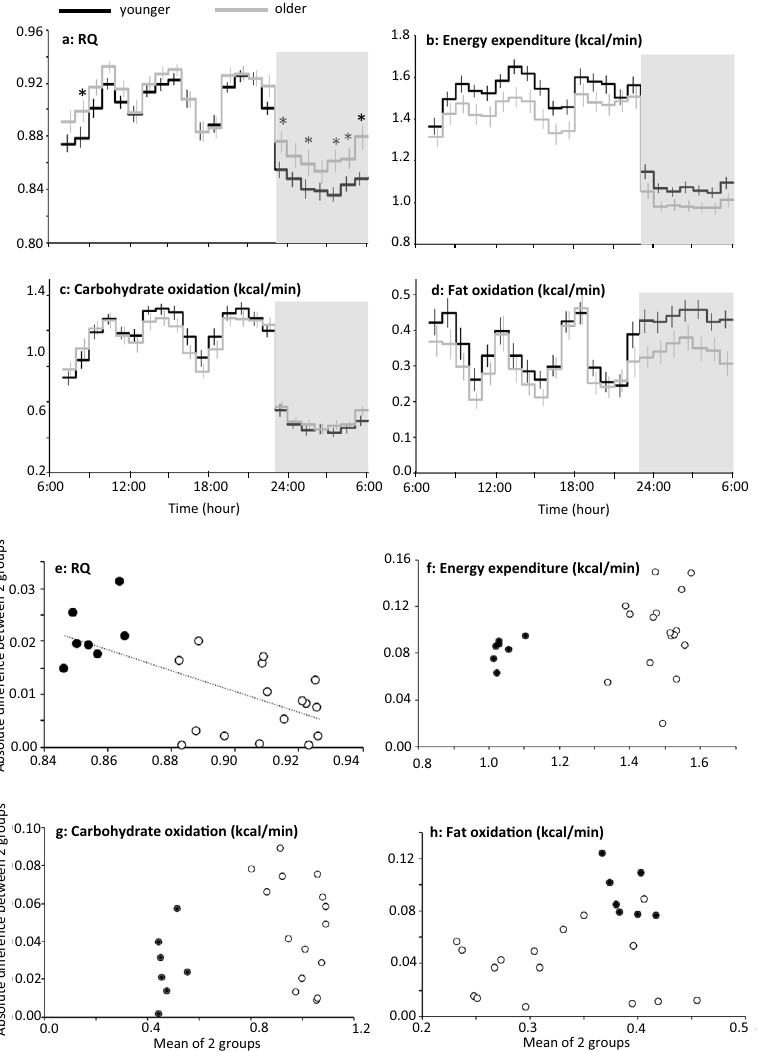
Figure 3. Time course of energy metabolism in two age groups of 10 years apart. ( a – d ) Fifty-three men were grouped as younger (n = 27, under 25 years of age) or older (n = 26, 25 years or more) 9,19–22 . Subjects took breakfast (7:00, 8:00 or 9:00), lunch (12:00, 12:30 or 13:00), and dinner (18:00), and slept for 7 or 8 h from 23:00 (grey bars). Because of unequal duration of sleeping period, the 8th hour of sleep in one experiment was not included for statistical analysis 9 . Mean ± SE of RQ, energy expenditure, carbohydrate oxidation and fat oxidation for 23 h common to all data sets were shown for younger (black lines) and older (grey lines) group. A linear mixed-models ANOVA showed a significant effect of time (P < 0.01) and a group × time interaction (P = 0.032), but main effect of group was not significant (P = 0.078) for RQ. Similarly for carbohydrate oxidation, significant effect of time (P < 0.01) and a group × time interaction (P = 0.043) were found, but main effect of group was not significant (P = 0.792). For energy expenditure and fat oxidation, main effect of time was significant (P < 0.01), but main effect of group (P = 0.066 for energy expenditure and P = 0.129 for fat oxidation) and group × time interaction was not significant (P = 0.376 and P = 0.290). *Represents significant difference between the 2 subgroups by post hoc pair-wise comparisons (P < 0.05). Significant difference in RQ in the morning requires cautious interpretation, since % of subjects who took breakfast before 9:00 was not matched; 52% in younger and 69% in older group, respectively. ( e – h ) Absolute difference between two age groups were plotted against mean of the two subgroups for RQ, energy expenditure, carbohydrate oxidation and fat oxidation. Values during sleep were shown as filled symbols (filled blue circles). Significant negative correlation between absolute difference and mean of the two subgroups was observed in RQ (P <